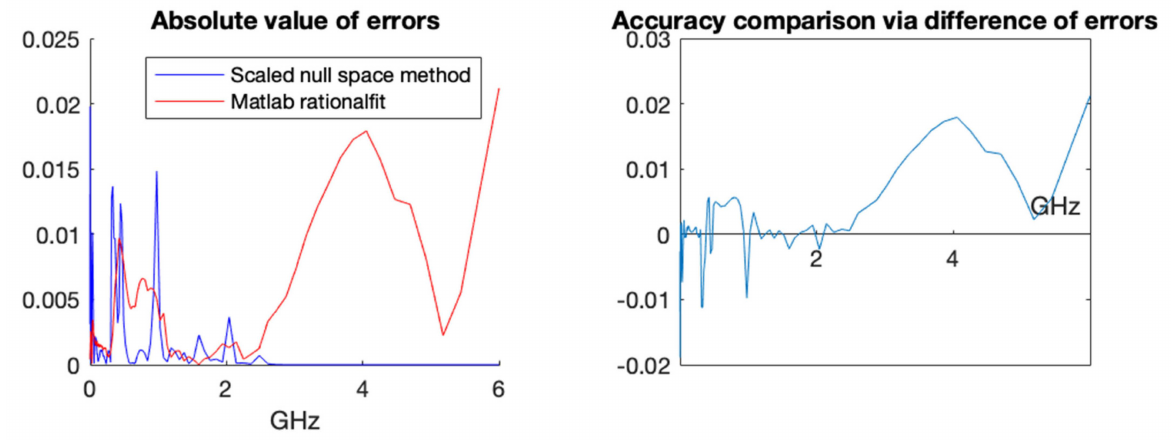
Figure 7. A pointwise comparison of fitting errors in the example above. Left-hand side graph shows absolute value of errors of our method scaled null space versus Matlab rationalfit. Right-hand